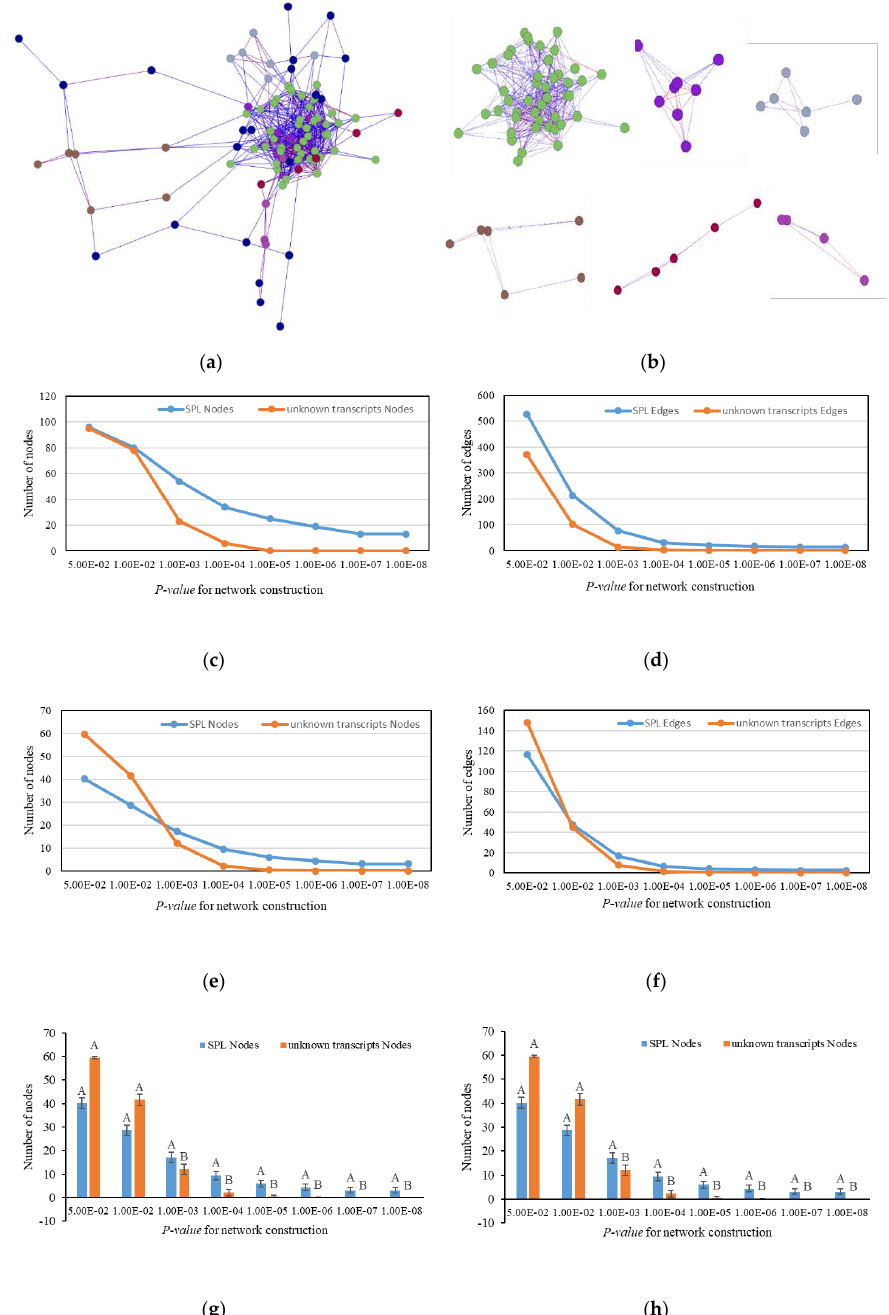
Figure 6. The network constructed at p ≤ 0.05, and its analysis of the PgSPL transcripts expressed in the 14 tissue of 4 years old ginseng. ( a ) The network of all transcripts. ( b ) The networks of clusters. ( c ) Trend that numbers of nodes of all PgSPL transcripts under different p -values with unknown genes as controls. ( d ) Trend that numbers of edges of all PgSPL transcripts under different p -values with unknown genes as controls. ( e ) Trend that numbers of nodes of randomly drawn 64 PgSPL transcripts under different p -values with unknown genes as controls. ( f ) Trend that numbers of edges of randomly drawn 64 PgSPL transcripts under different p -values with unknown genes as controls. ( g ) Statistics of the numbers of nodes of randomly drawn 64 PgSPL transcripts under different p -values with unknown genes as controls. ( h ) Statistics of the numbers of nodes of randomly drawn 64 PgSPL transcripts under different p -values with unknown genes as controls. In (g) and (h), the error bars are standard deviation for 20 replications.